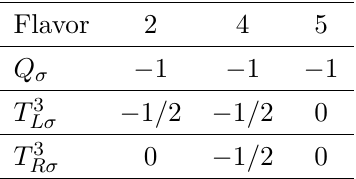
Table 3 . This table shows the electric charge Q σ and the third component of weak isospins T 3 and T 3 for each flavor considered in the mixing of charged leptons. Recall that in the flavor basis, Rσ we have 2 = µ, 4 = L , and 5 = E